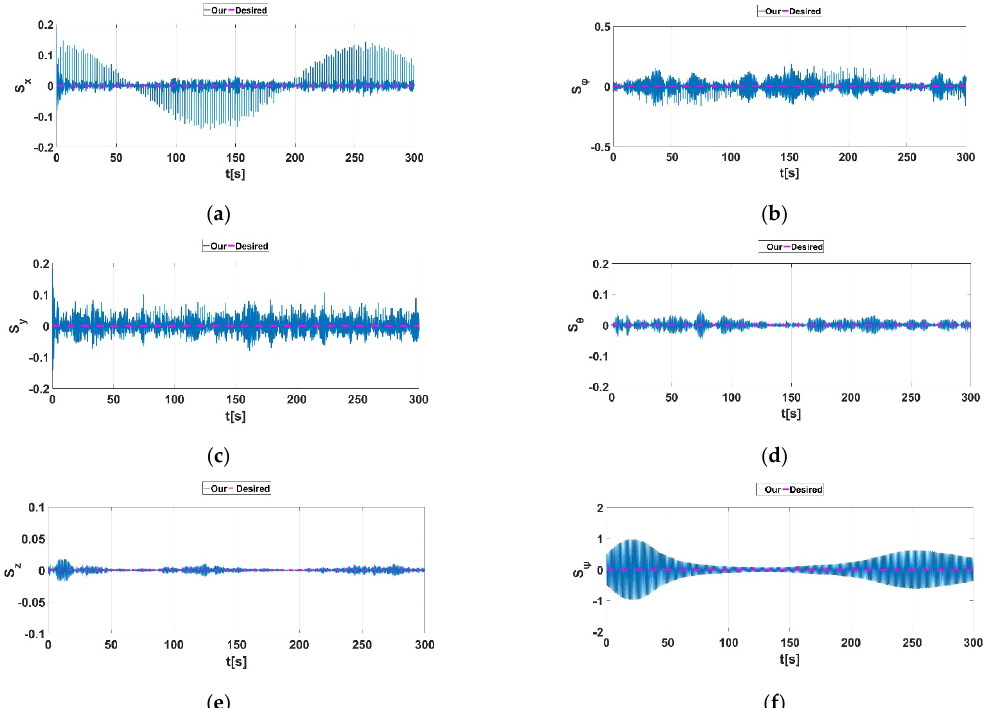
Figure 8. AUV velocity − tracking errors. ( a ) 𝑢 𝑒 ; ( b ) 𝑝